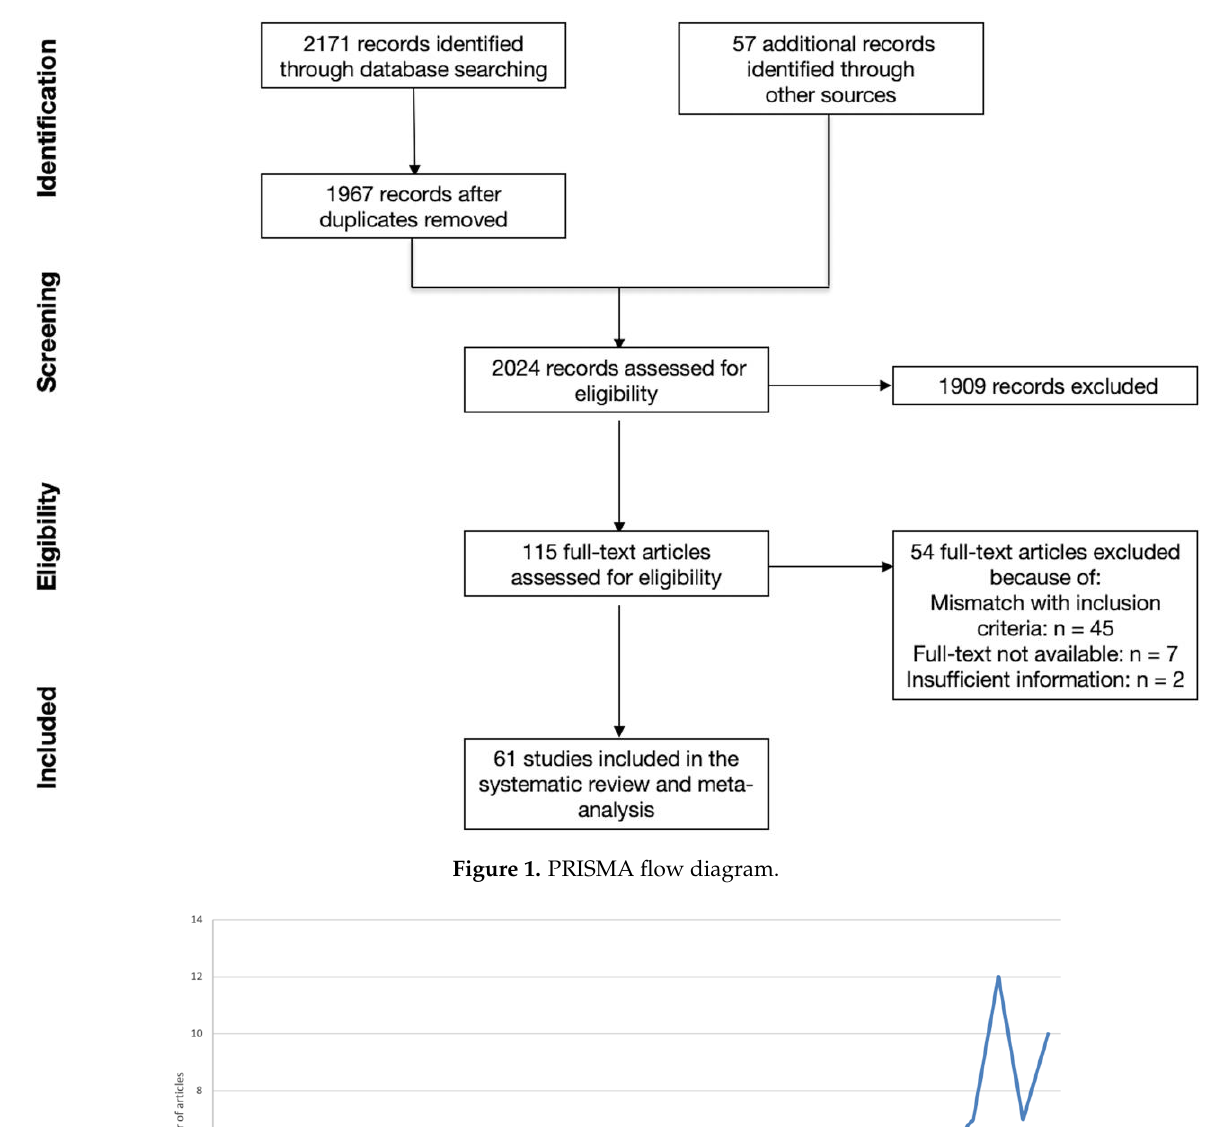
Figure 2. Publishing timeline of the included studies.